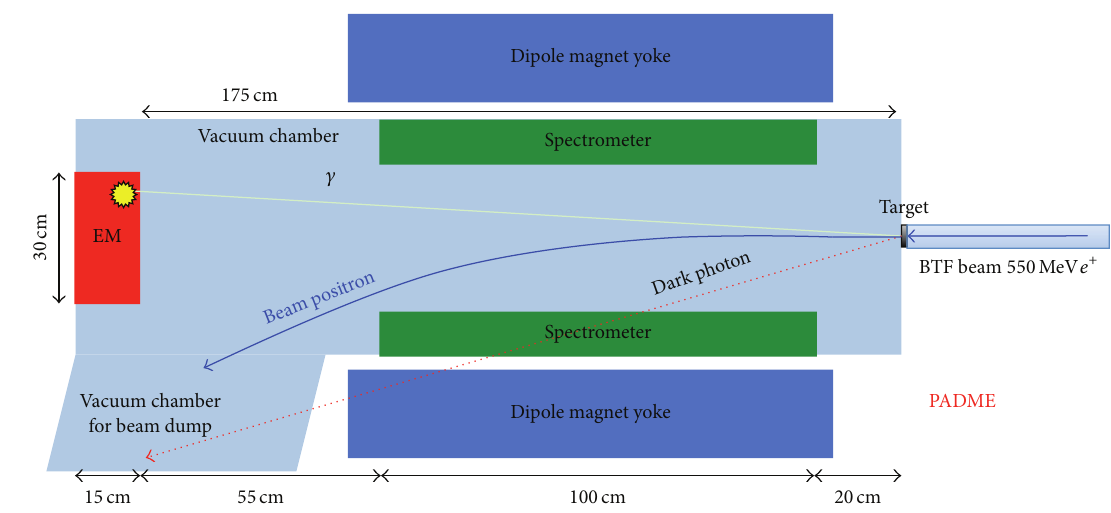
Figure 5: Schematic of the Positron Annihilation into Dark Matter Experiment (PADME). Table 1: BTF beam parameters [32]. A possible increase of the performance after an upgrade is also shown. 𝑒 + 𝑒